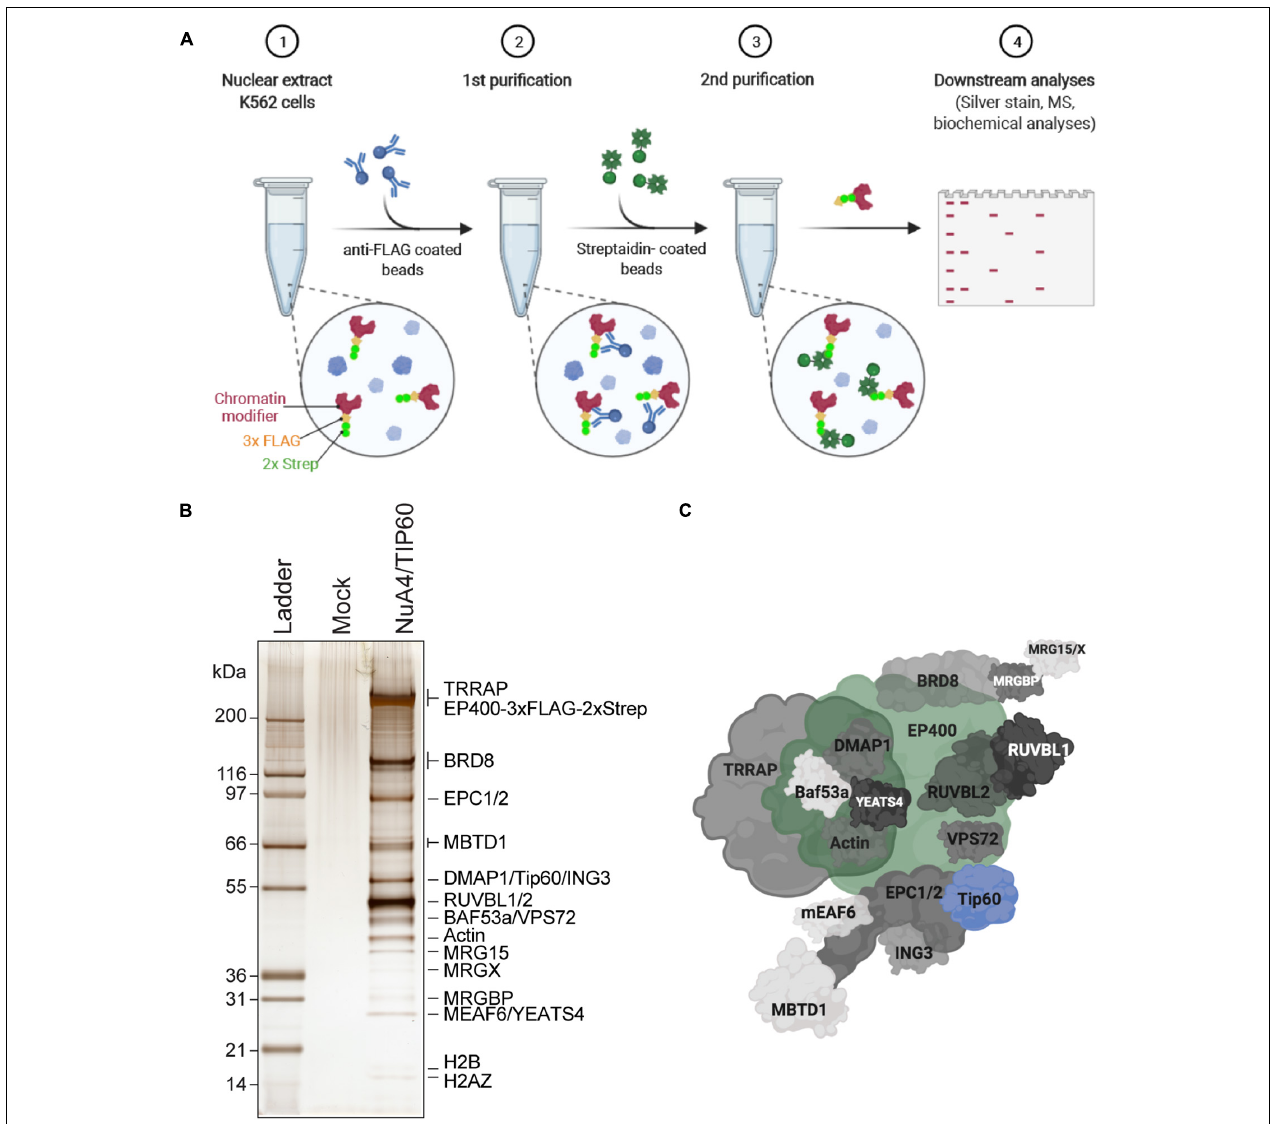
FIGURE 1 | Purification of endogenously tagged native chromatin modifying enzymes (A) TAP. Step 1: Nuclear extracts are isolated from engineered K562 cell lines (here, C-terminally 3 × FLAG-2 × Strep-tagged endogenous EP400 was used as an example). Step 2: FLAG-Strep-tagged proteins are immunoprecipitated using anti-FLAG-coated beads and eluted with 3 × FLAG peptides. Step 3: Eluted FLAG-Strep-tagged proteins are isolated using streptavidin-coated beads and eluted with biotin. Step 4: Purified FLAG-Strep-tagged proteins are either analyzed by silver staining and/or MS, or directly used in biochemical assays. Created with BioRender.com. (B) Silver-stained purified NuA4/TIP60 native complex after TAP of 3 × FLAG-2 × Strep-EP400. K562 cells expressing the 3 × FLAG-2 × Strep tag alone (mock) were used as a control purification. (C) Schematic representation of the NuA4/TIP60 complex. The TIP60 subunit, which encompasses the acetyltransferase activity of the complex, is colored in blue and the tagged subunit EP400 is colored in green. Created with